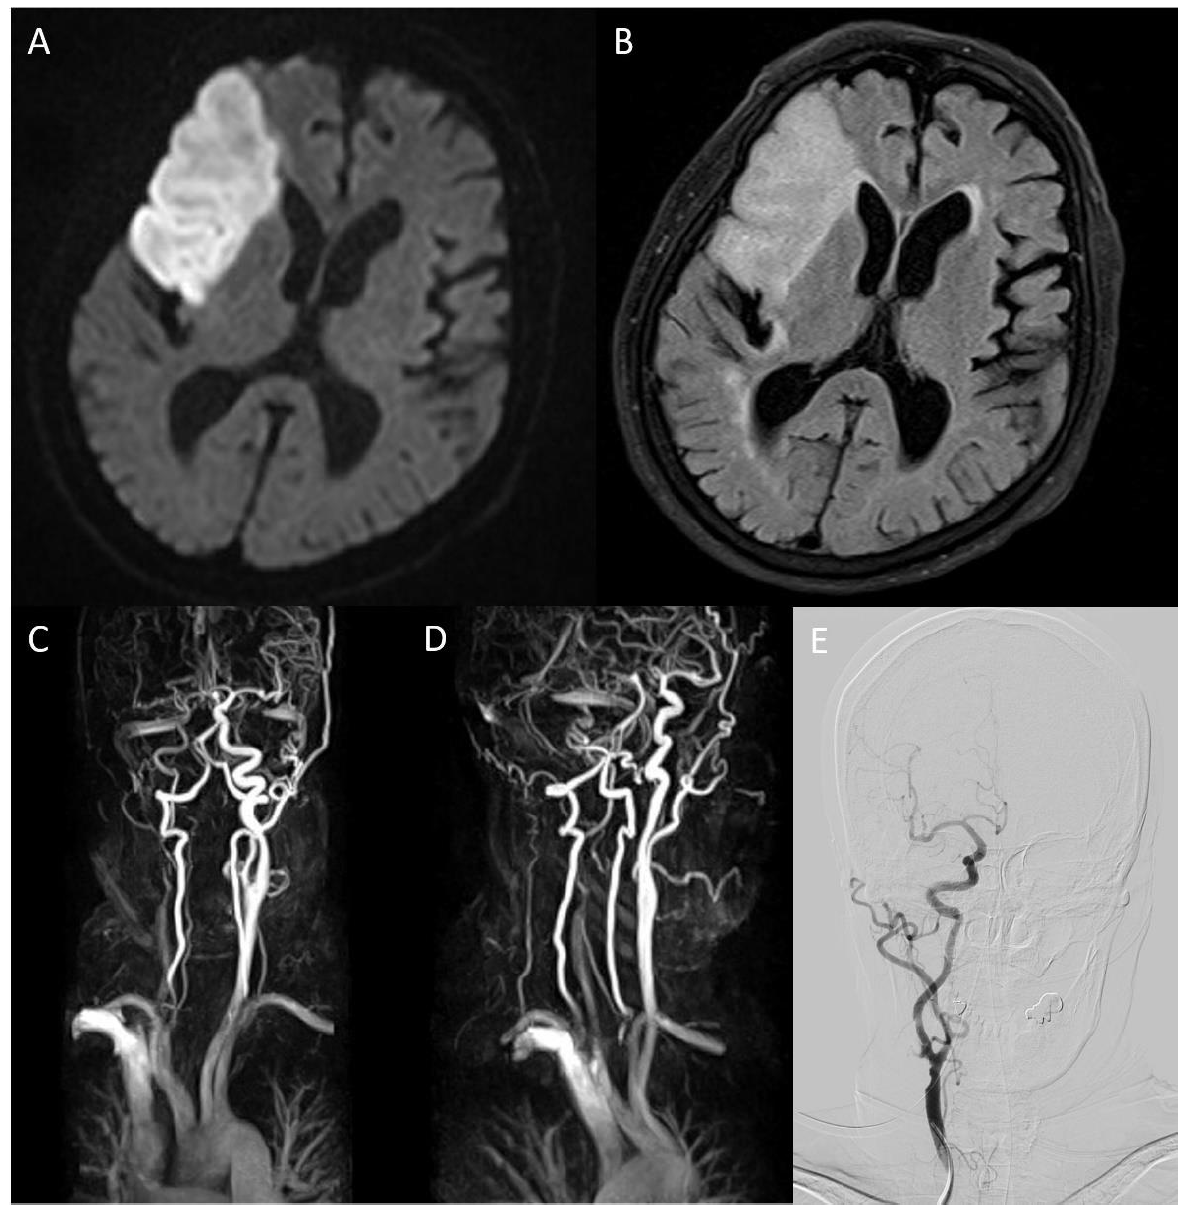
Figure 1. On brain magnetic resonance diffusion-weighted image (DWI) conducted after admission, infarction in middle cerebral artery territory was confirmed ( A ). On fluid-attenuated inversion recovery, high-intensity signals in the same area were detected ( B ). Magnetic resonance angiography (MRA) showed severe stenosis ranging from the right carotid bulb to the right ICA, causing decreased blood flow to the brain ( C , arrow). The overall state of the carotid bulb and ICA was examined through sagittal rotation of MRA ( D ). Spontaneous regression of former severe stenosis to mild degrees was confirmed on right ICA angiography of digital subtraction angiography on hospitalization day 16 ( E ).